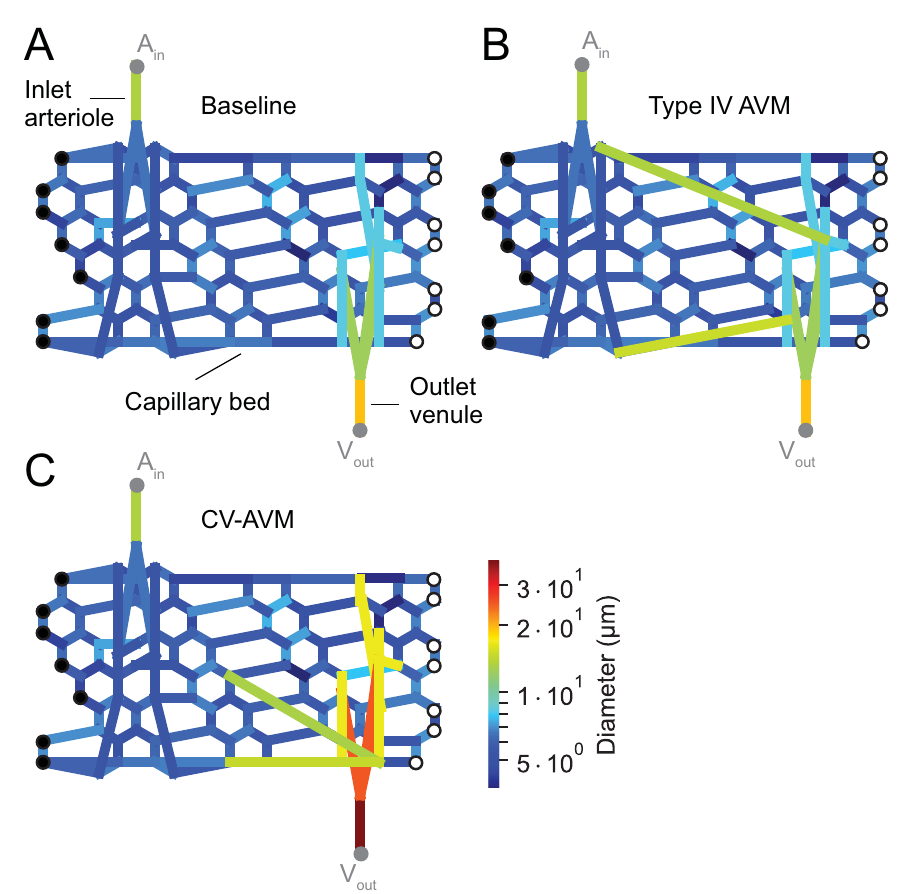
Fig 2. Prototype capillary bundle elements and microvascular AVMs. Schematic representation of a capillary bundle element with feeding arteriole and draining venule. (A) Baseline: physiological reference condition; (B) Type IV: example of Yakes type IV AVM; (C) CV-AVM: hypothesized morphology of a hyperdynamic CV-AVM.